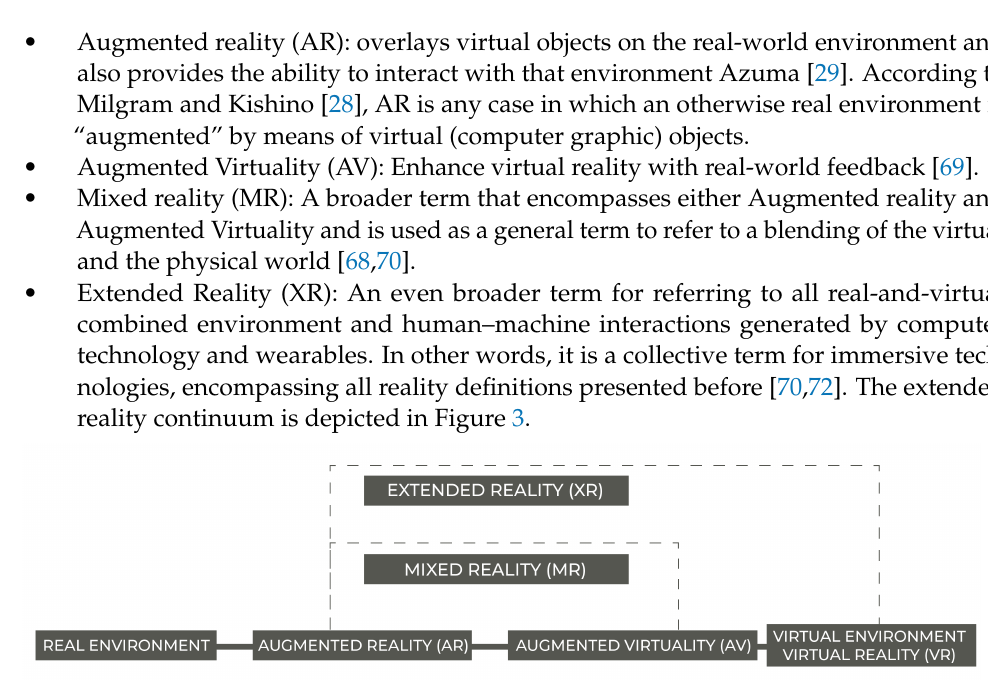
Figure 3. Extended Reality continuum.